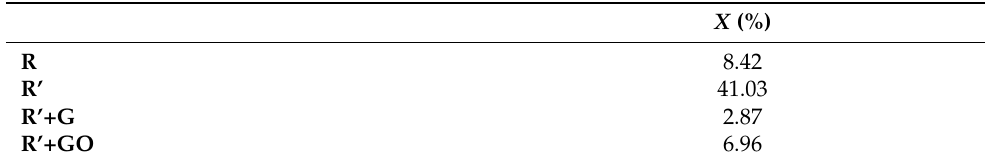
Table 8. Degree of polymerization of samples subjected to UV for 2 s.